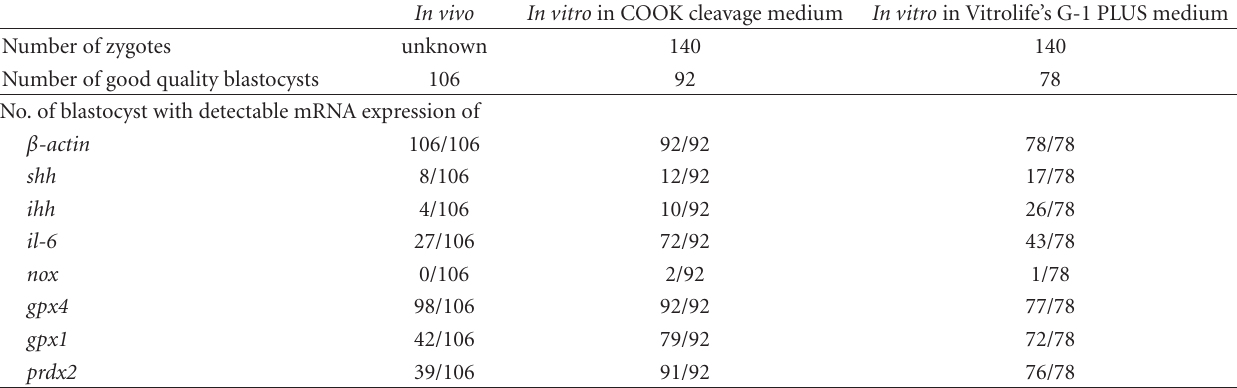
Table 2: Number of zygotes developed to blastocyst in correlation with gene expression of the mRNAs of interest. In vivo In vitro in COOK cleavage medium In vitro in Vitrolife’s G-1 PLUS medium Number of zygotes unknown 140 140 Number of good quality